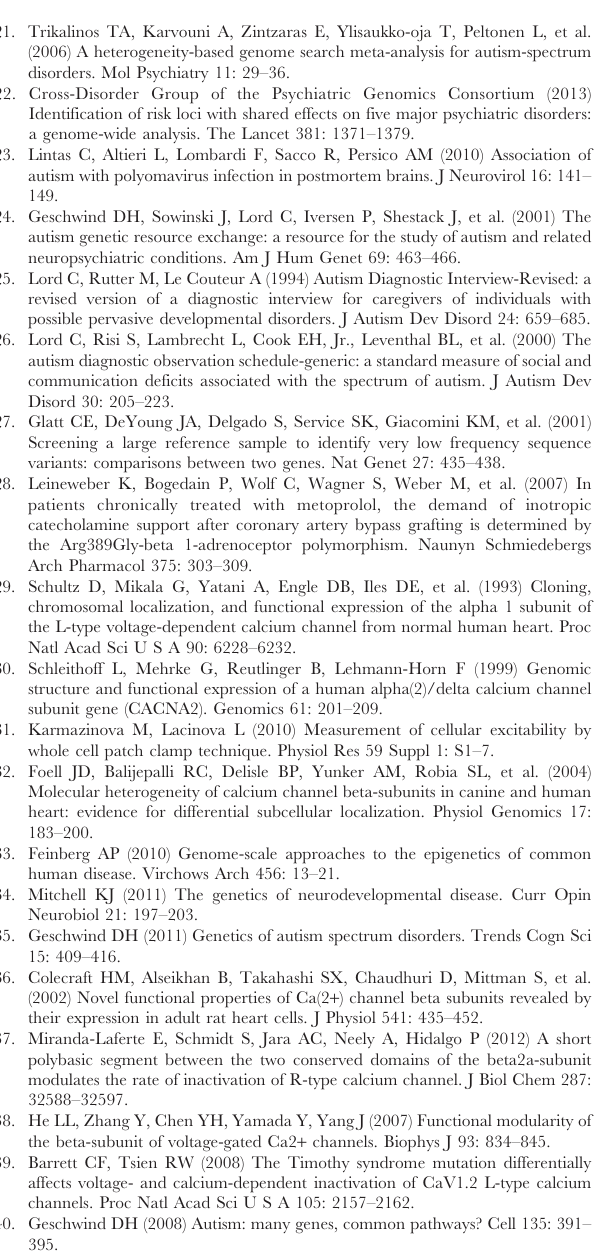
Table S2 Current and voltage parameters (mean ± SEM) of the constructs tested. P-values stem from individual Student t-tests of the indicated